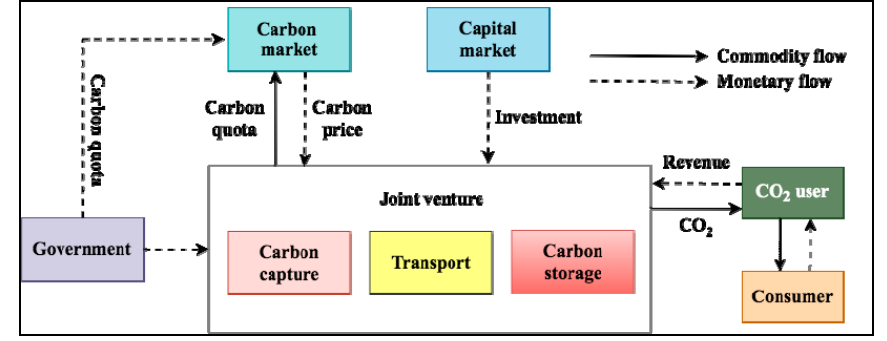
Figure 5. Joint venture CCUS business model.